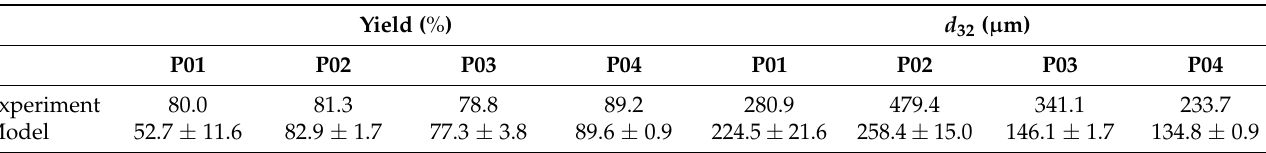
Table 5. The comparison of yield and final mean crystal size ( d 32 ) between the experimental measurements and the model predictions (Monte Carlo (MC) model predictions are shown with 95% confidence